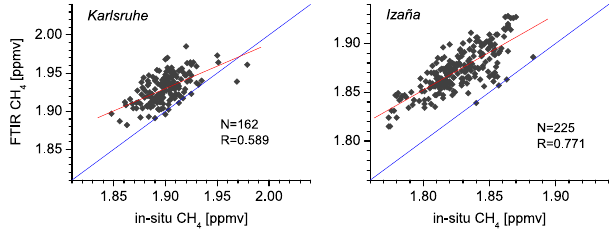
Figure 8. Correlation plot between coincident tropospheric CH 4 daily medians obtained by NDACC FTIR and in situ GAW for the Karlsruhe (left graph) and Izaña (right graph) FTIR sites. The blue lines indicate the 1 : 1